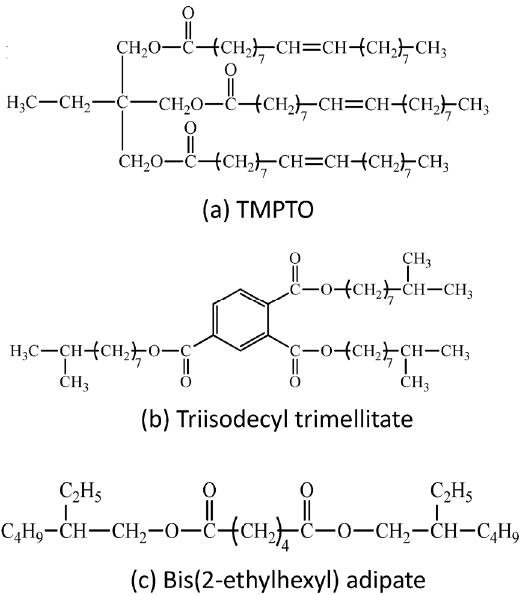
Fig. 13 Molecular structural formula of base oil.